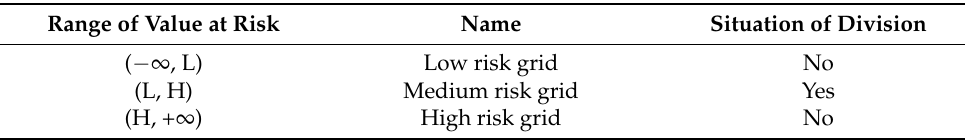
Table 1. Triggering rule of grid division. Range of Value at Risk